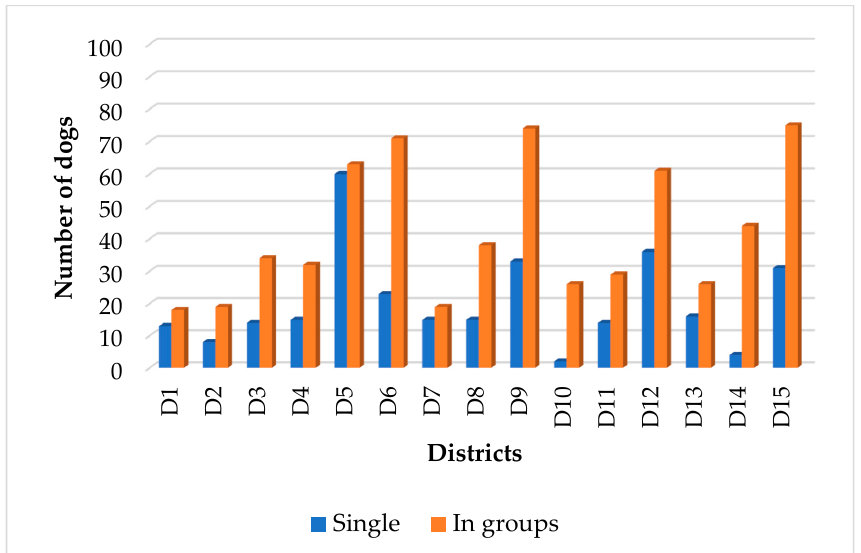
Figure 8. Group structure of FRD population during the survey period in Herat city. UM/UF (one male with one female), UM/MF (one male with multiple females), MM/MF (multiple males with multiple females), MM/UF (multiple males with one female), MM/0 (group of multiple males), FF/0 (group of multiple females), MUN/0 (group of multiple unverified gender), UUN/UM (one of unverified gender with one male), UUN/UF (one of unverified gender with one female), UM/MUN (one male with multiple of unverified gender), UF/MUN (one female with multiple of unverified gender), UUN/MF (one of unverified gender with multiple females), MUN/MMF (multiple of unverified gender with multiple males and females).